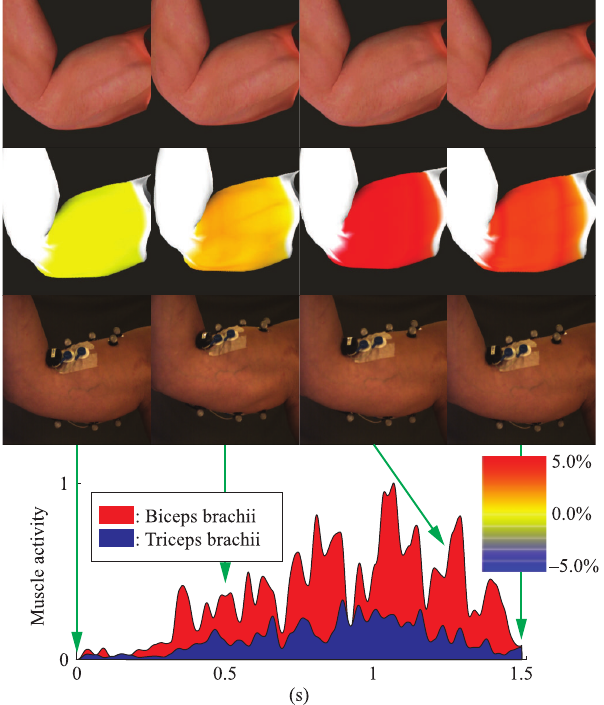
Fig. 5 Skin deformation simulation with muscle co-contraction. Top: skin deformation simulation. Middle: the increase in the upper arm perimeter. Yellow and red colors indicate the amount of muscle bulging. Bottom: activities of the biceps brachii and triceps brachii measured by